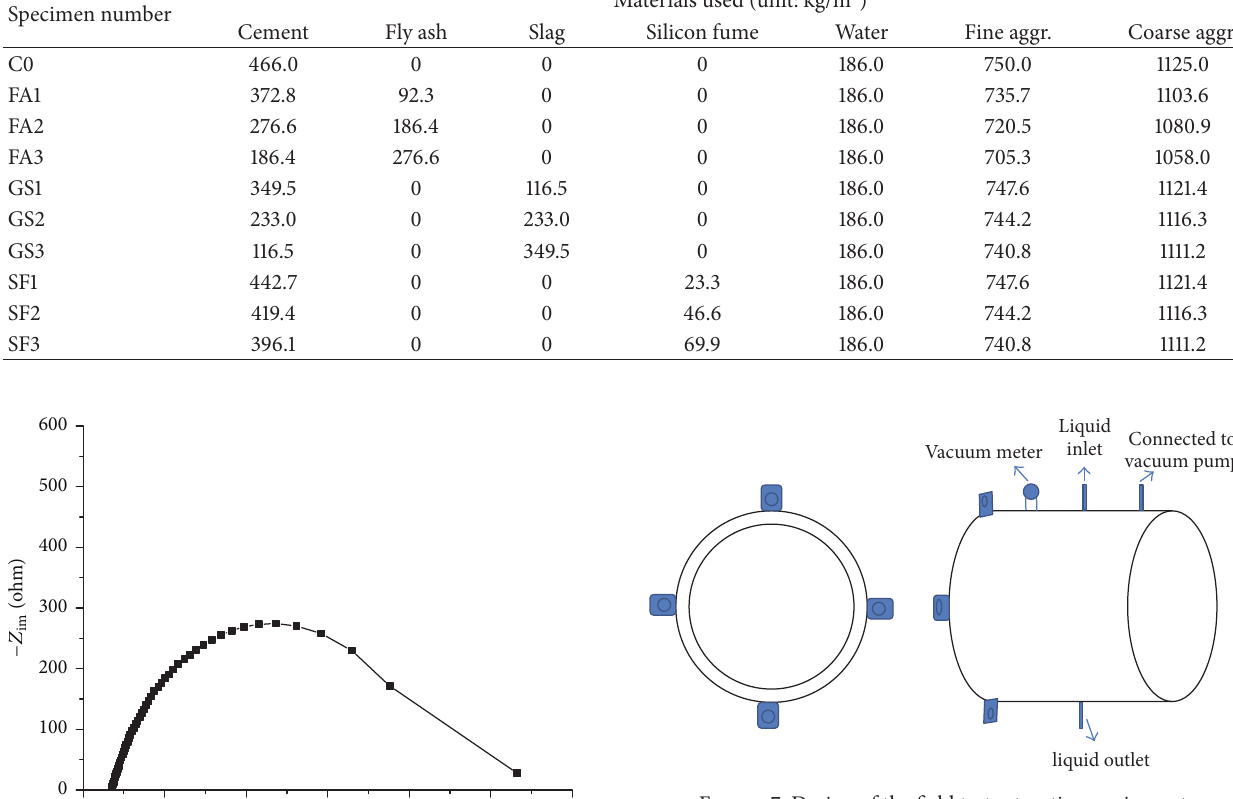
Figure 7: Design of the field test saturating